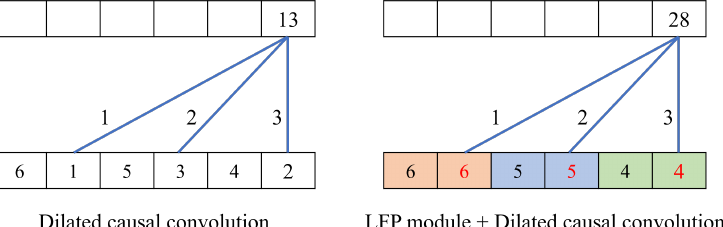
Figure 4. Toy example of the LFP module: the sequence of ( 6,1,5,3,4,2 ) is convoluted with and with- out the LFP module. The dilated causal convolution has a filter kernel of ( 1,2, 3 ) and a dilation rate of two. The LFP module extracts salient features from neighboring elements in the dilation